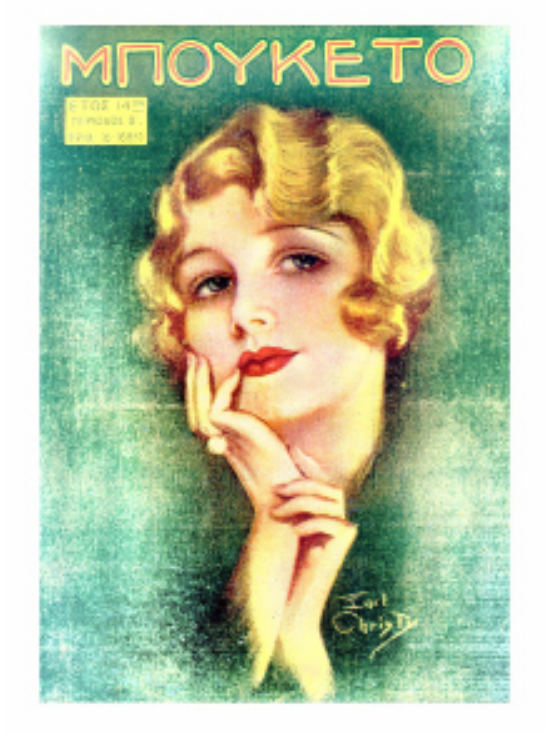
Fig. 1 Cover of Μπουκέτο in 1937, featuring an illustration by F. Earl Christy (1882–1961). Several other covers from American illustrators were reprinted in Μπουκέτο . Collections of Hellenic Literary & Historical Archive